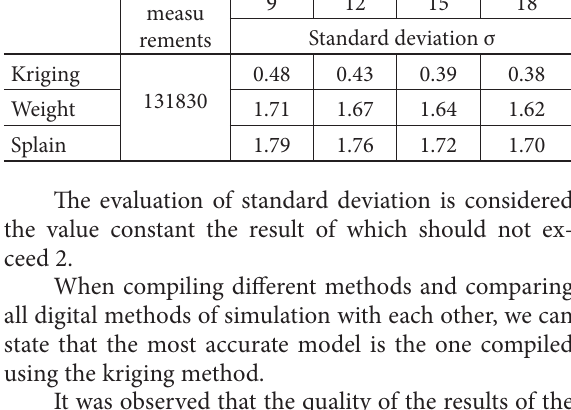
Fig. 9. A model obtained using the weight method Table 5. The accuracy of different methods for simulation Simulation